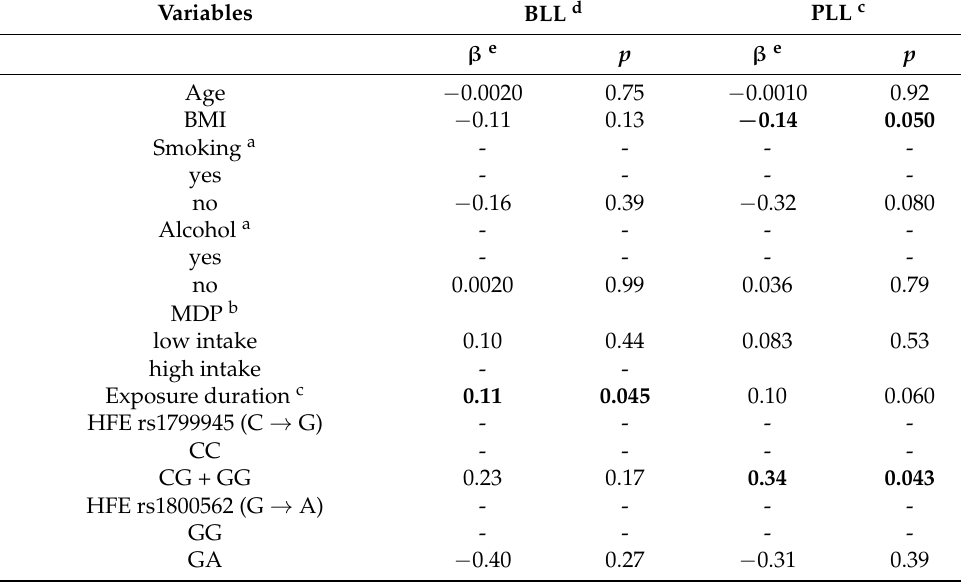
Table 2. Impact of HFE polymorphisms on blood lead levels (BLL) and plasma lead levels (PLL) adjusted for age, body mass index (BMI), exposure period, smoking, alcohol, and milk and dairy product (MDP)